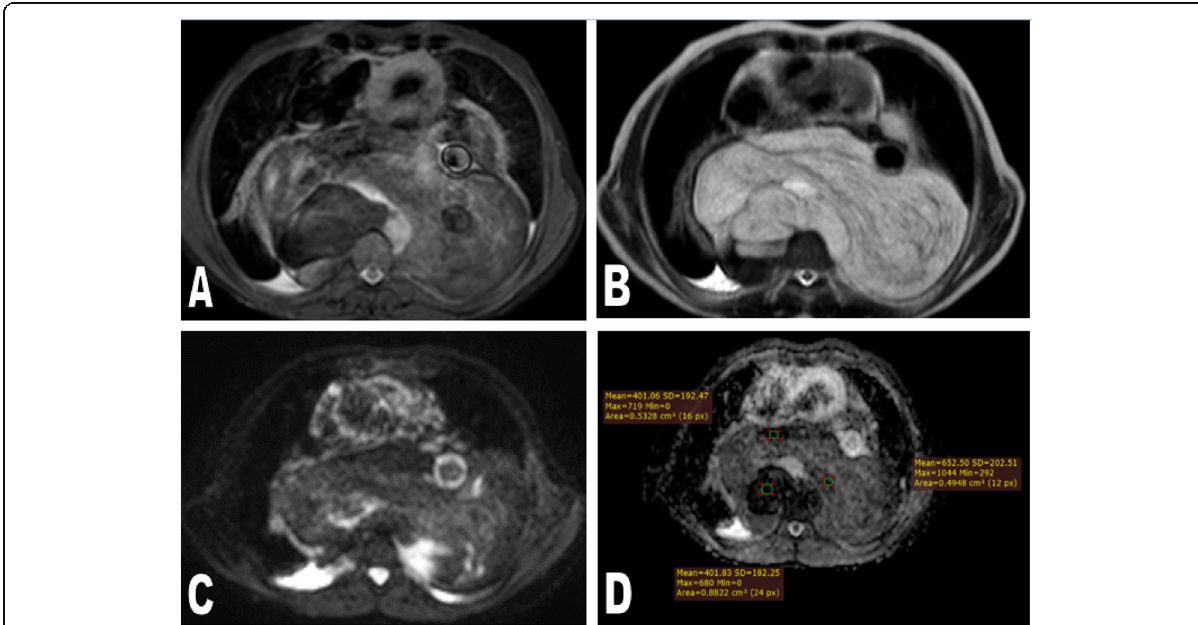
Fig. 6 Case of liposarcoma. A 60-year-old male patient presenting with progressive loss of weight, chest pain, and dyspnea. MRI chest ( a ) axial STIR, ( b ) axial T2, ( c ) DWI, and ( d ) ADC map: showing large posterior mediastinal mass of hyper intense signal on T2 WI, intermediate signal on STIR with patchy hyperintense areas on DWI, and low signal on ADC map (restricted diffusion). The mean ADC value was 0.5 × 10 − 3 mm 2 /s. Bilateral minimal pleural effusion is noted